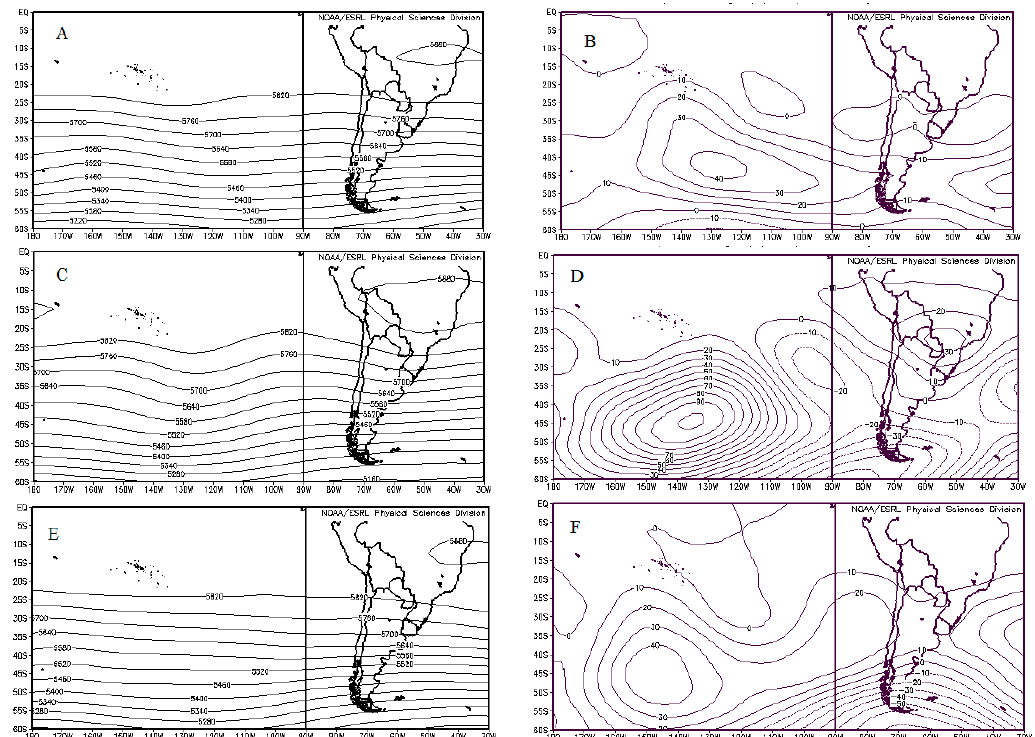
Figure 4. As in Figure 2 except for the composites of all June years for ( A , B ) negative transitions; ( C , D ) positive transitions; and ( E , F ) steady state